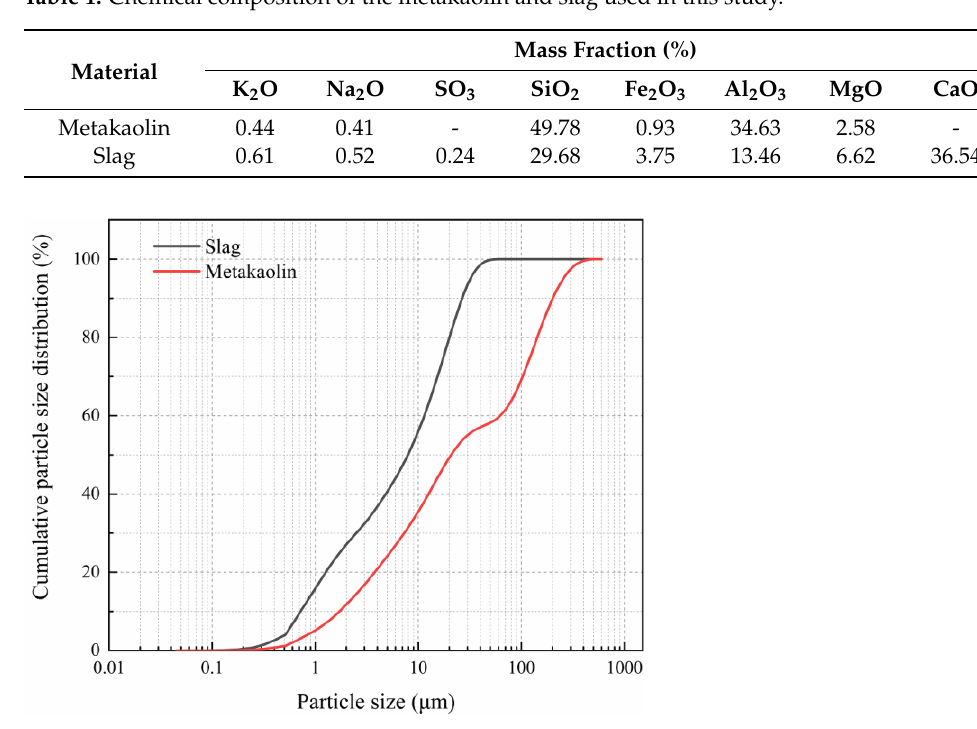
Figure 1. Cumulative particle size distribution of the metakaolin and slag used in this study.